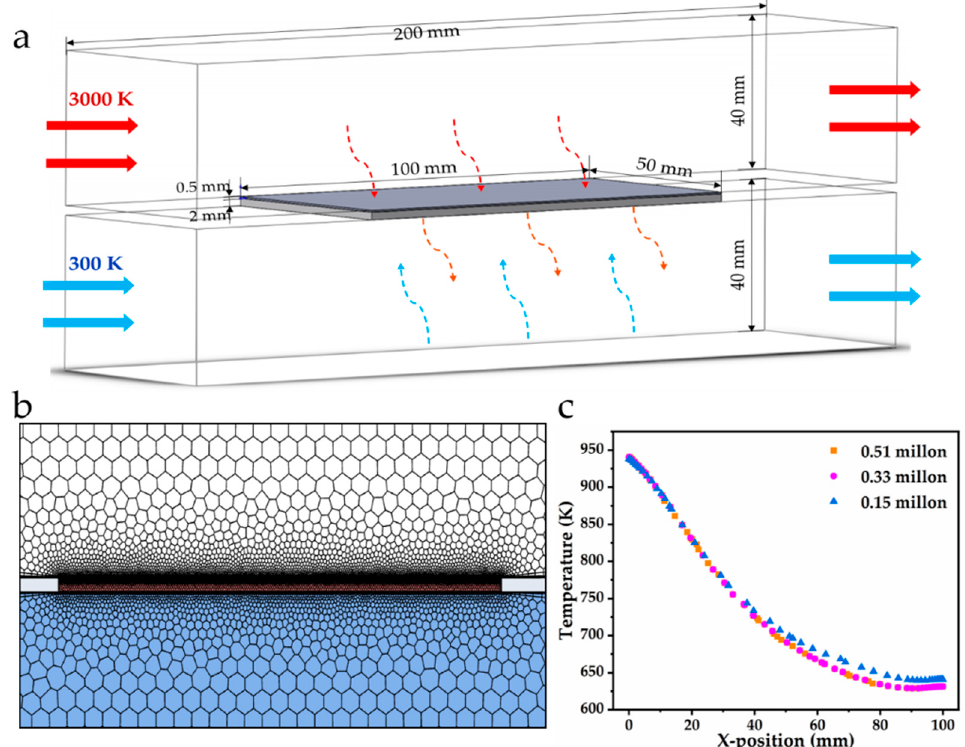
Figure 5. ( a ) Calculation domain and boundary conditions of structure; ( b ) unstructured meshes; ( c ) mesh independence verification.